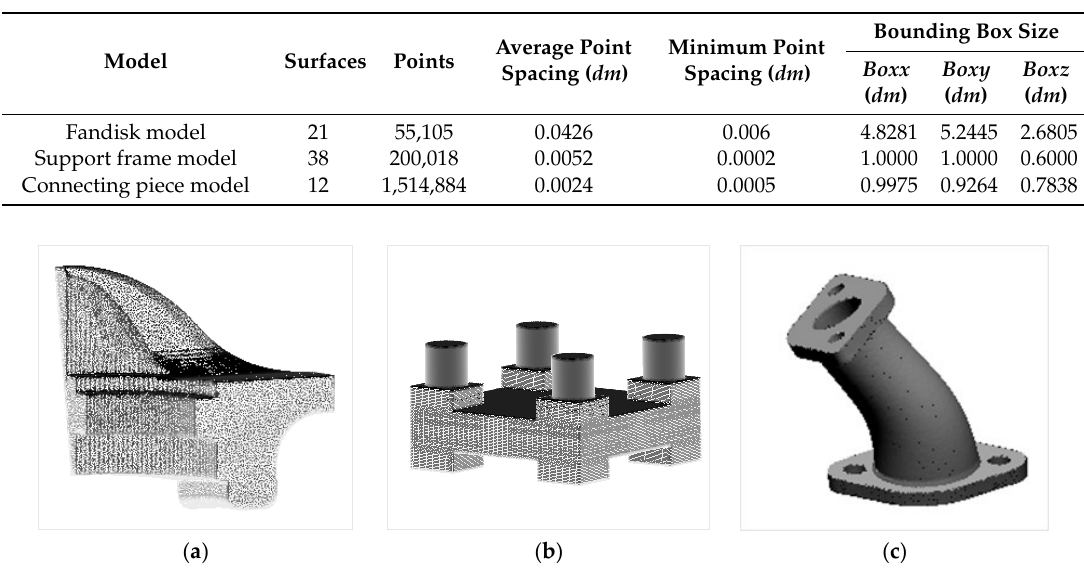
Table 2. Point cloud data of the three models.